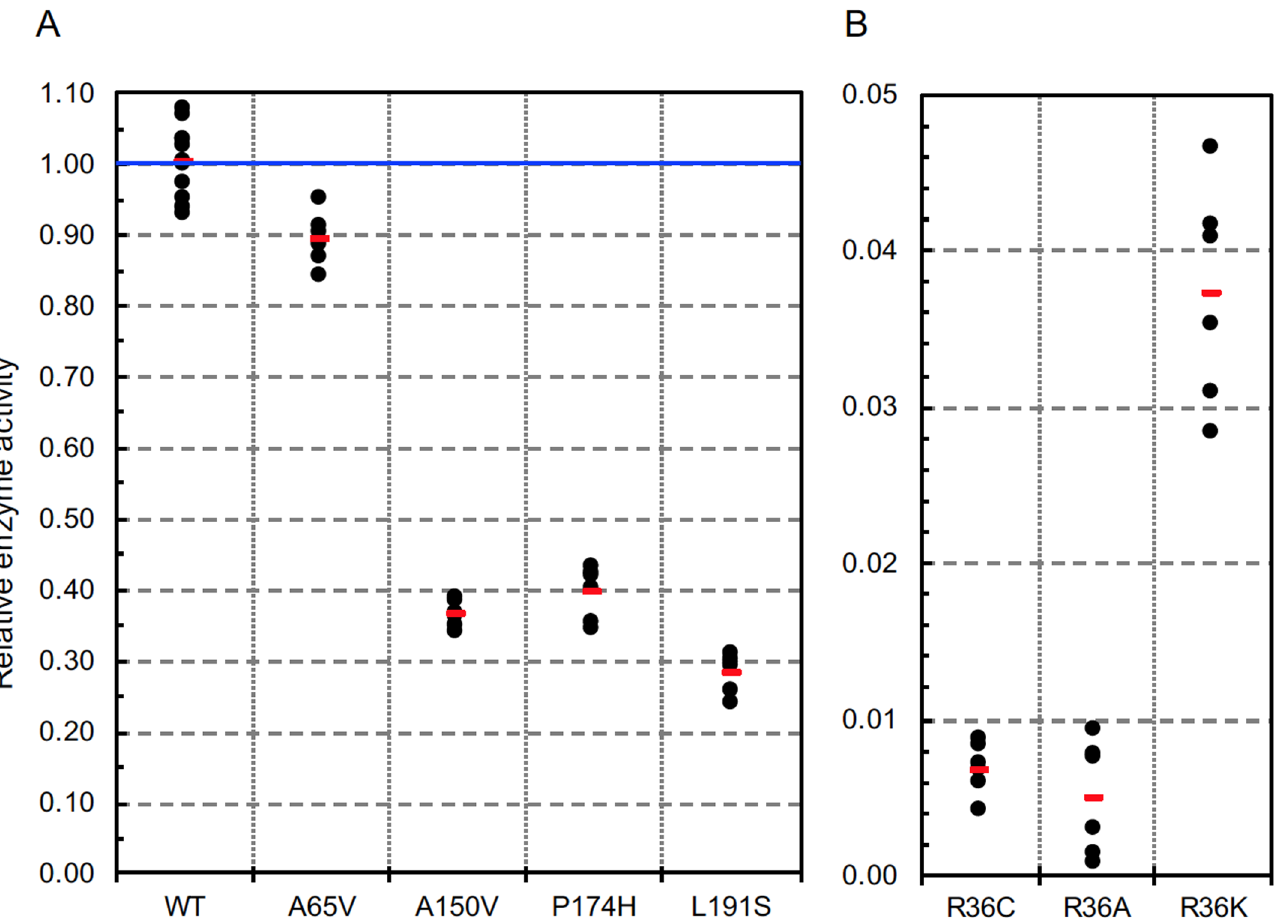
Fig 3. Relative enzyme activities using 5 mg/ml bovine γ -globulin as the methyl acceptor. Assays for each variant were carried out twice, each time in triplicate. Triplicates of the WT enzyme were always assayed in parallel with each variant to provide optimal normalization. Each data point ( ● ) shown in the figure was normalized by dividing the 3 H-methyl cpm obtained in that assay by the average of triplicate WT assays done in parallel. Red bars indicate the average of the variant data points. Although not always evident due to symbol overlap, there are six data points for each mutant, and 12 for the WT. In panel B, note the vertical scale is greatly amplified due to the very low activity of all three R36